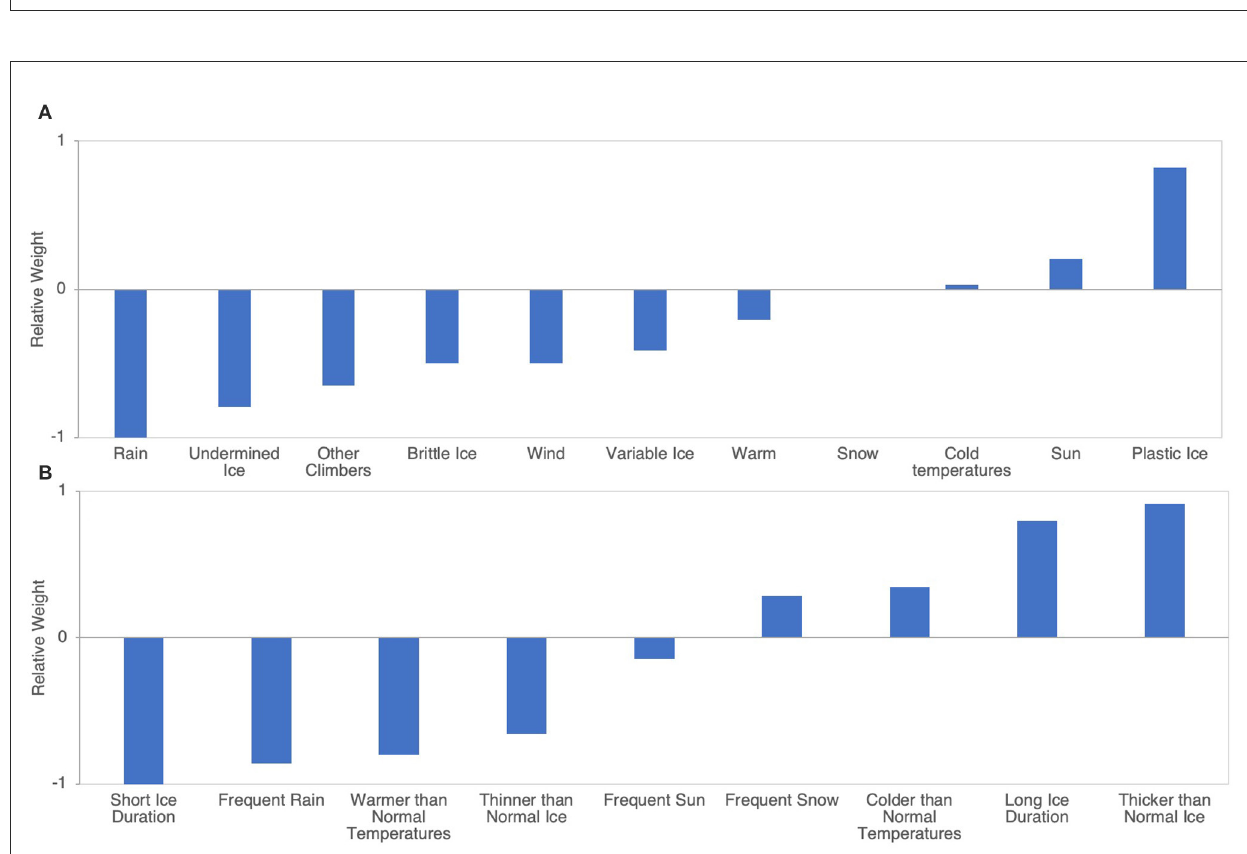
FIGURE7 Variable affecting guides’ ability to deliver positive experiences to guests (A) over the course of a given day and (B) over the course of a season. Negative values indicate parameters reduce guides abilities to deliver positive experiences; positive values indicate parameters improve guides abilities to deliver positive